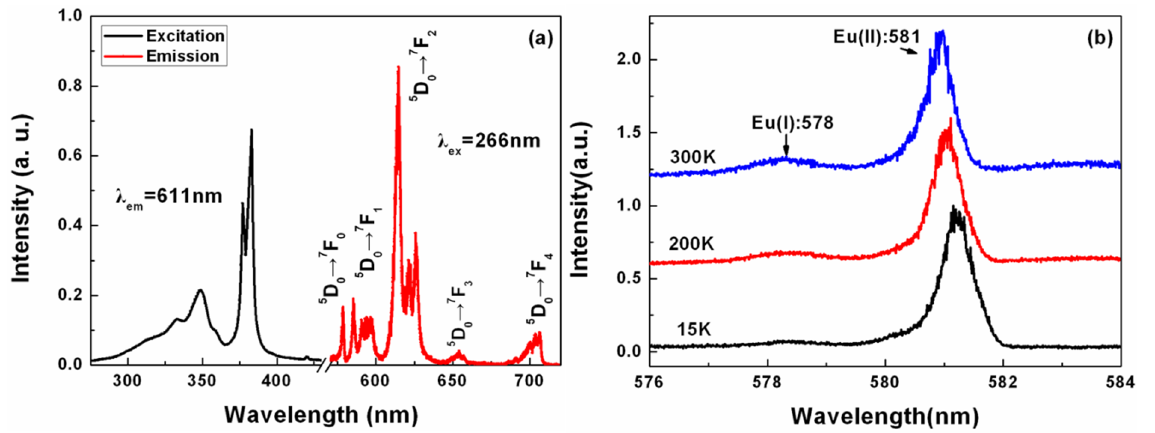
Figure 17. ( a ) Room temperature excitation and emission spectra; ( b ) temperature dependent excitation spectra of 7F0-5D0 transition. Reprinted with permission from [30].